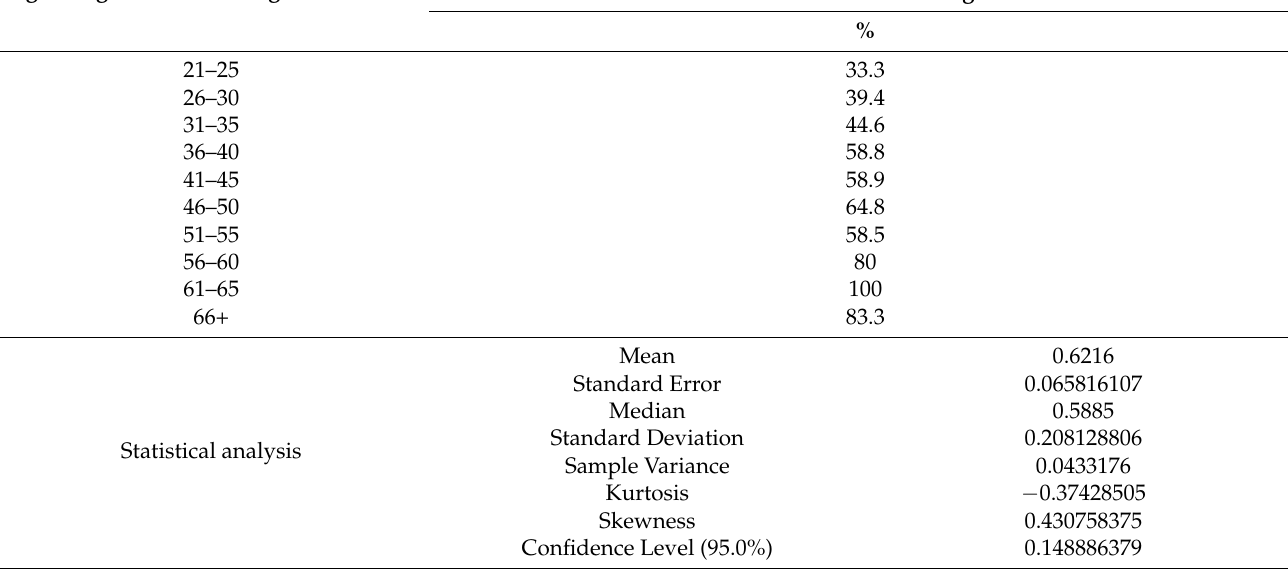
Table 7. Parents agree to vaccinate their children when they reach the recommended minimum age or when vaccines will be available for their